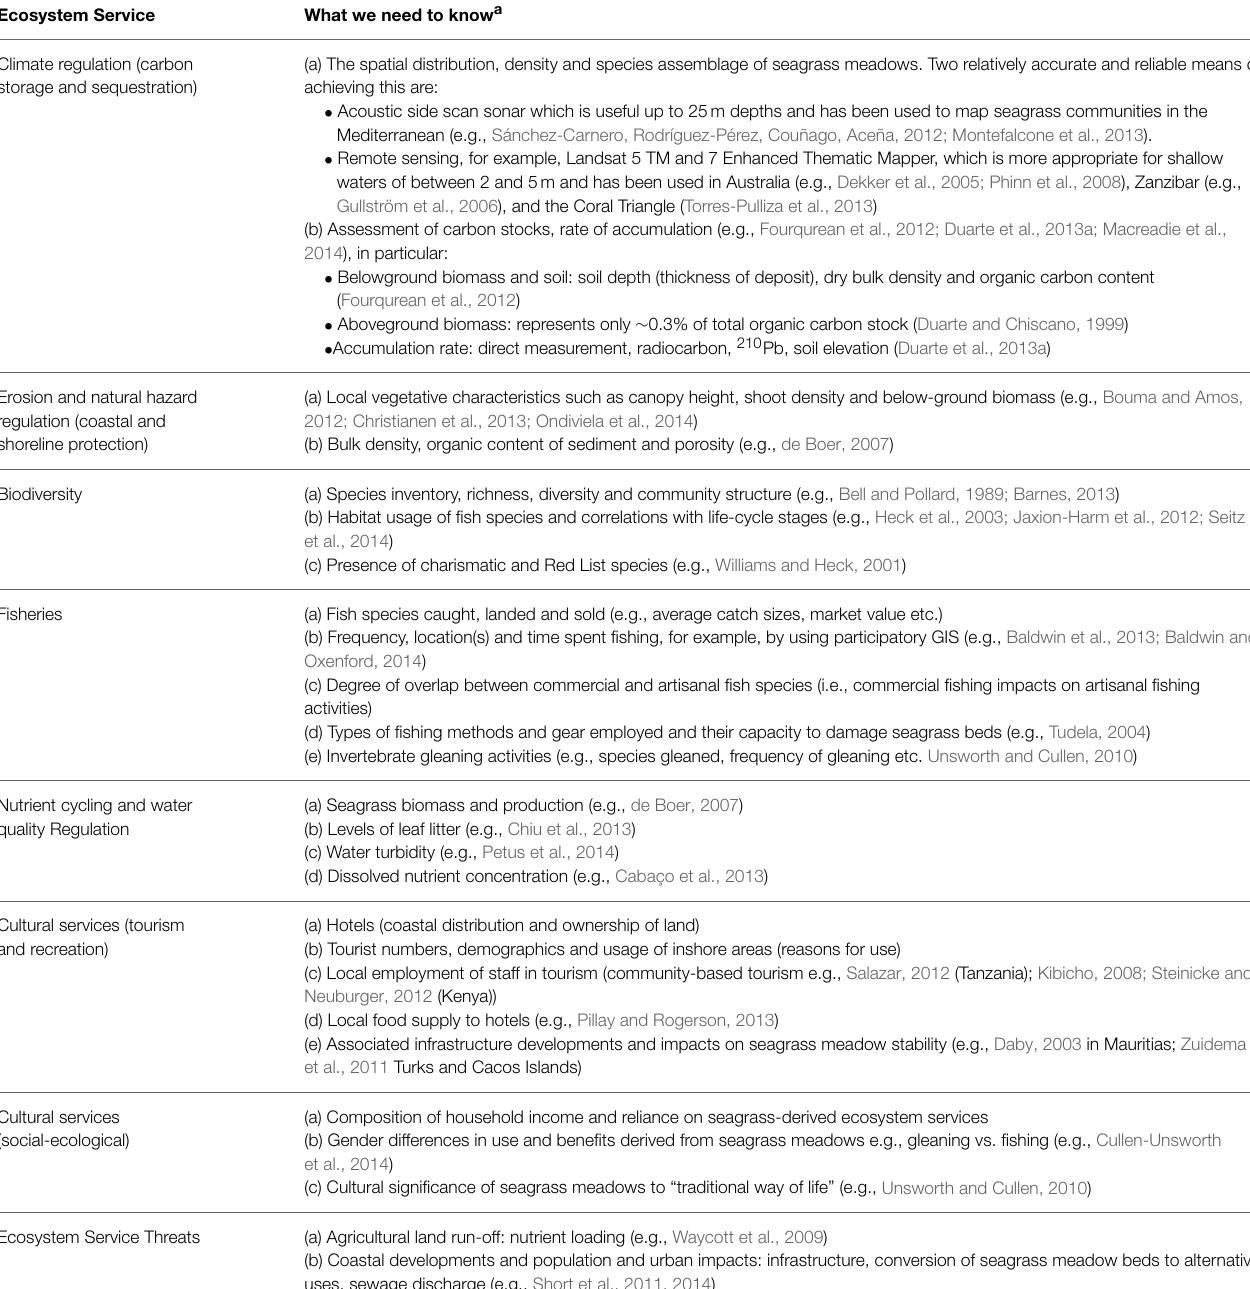
TABLE 1 | Seagrass ecosystem services and the corresponding information needed to contribute toward incentive scheme